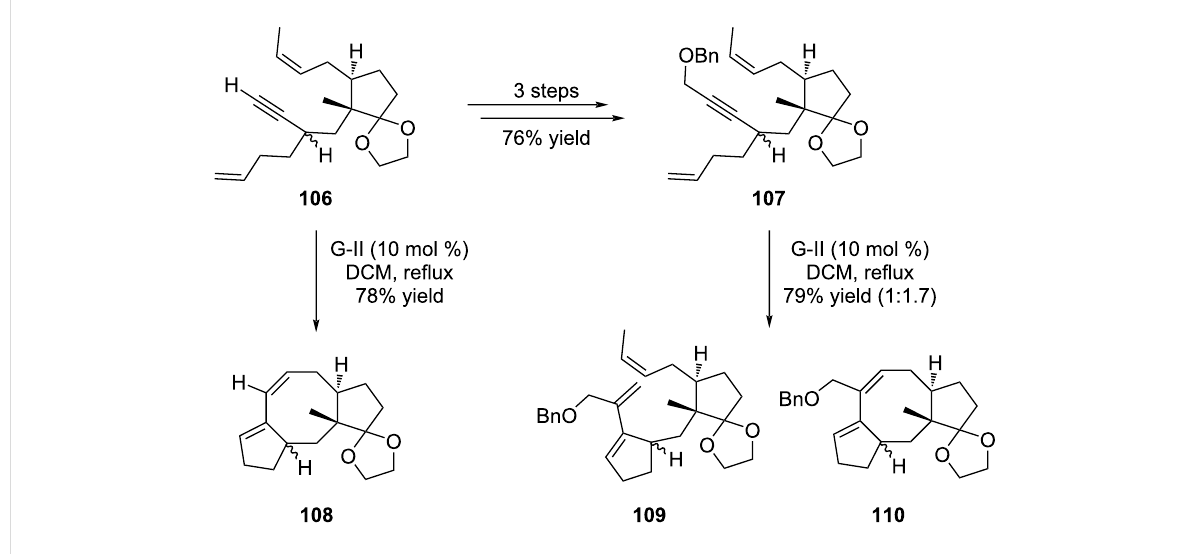
Scheme 19: TRCM on optimized substrates towards the synthesis of ophiobolin A ( 8 ).